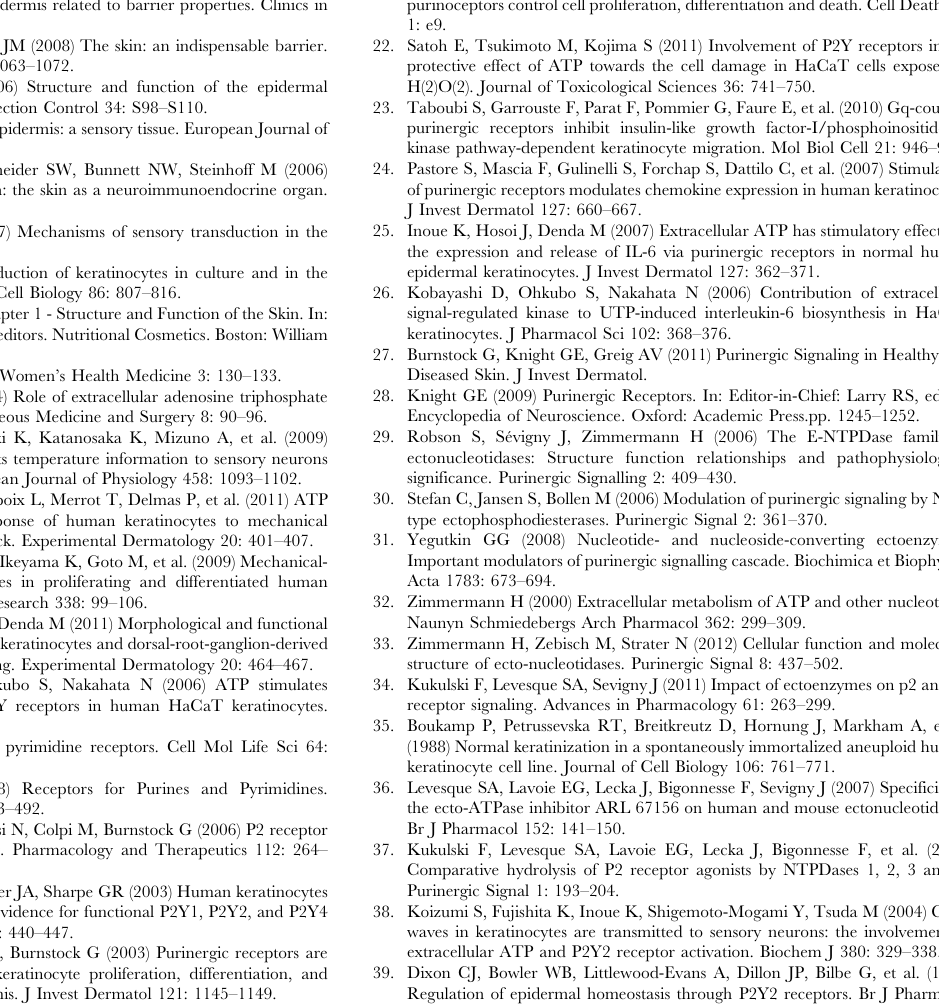
Figure S4 Serum has high ATPase activity and hydro- lyzes ATP in a dose-dependent manner. Bars denote the concentration of remaining ATP when 100 nM ATP was incubated with DMEM, FCS, or conditioned medium (CM, collected from a 48-hr culture) at the indicated volumes in the absence of HaCaT cells at 37 u C for 60 min. FCS was pre-diluted to 10% in DMEM to be comparable to the serum level in CM [mean 6 SEM, n = 5, two-way ANOVA followed by Tukey’s multiple comparison test comparing all columns to mock treatment (solid bars), *** p , 0.001; ns=not significant]. (TIF) Figure S5 The relative mRNA levels 96 hr after gene- specific siRNA knockdown. Two pre-designed siRNAs were used to verify gene-specific knockdown of NTPDase2, NTPDase3, and NTPDase8. P2Y1 and P2Y2 were knocked down using one validated gene-specific siRNA. Values are normalized to non- targeting control siRNA (dark gray bar, mean 6 SEM, n = 3 to 12, one-way ANOVA with Dunnett’s post-analysis comparing all columns to non-targeting control siRNA, *** p , 0.001). (TIF)